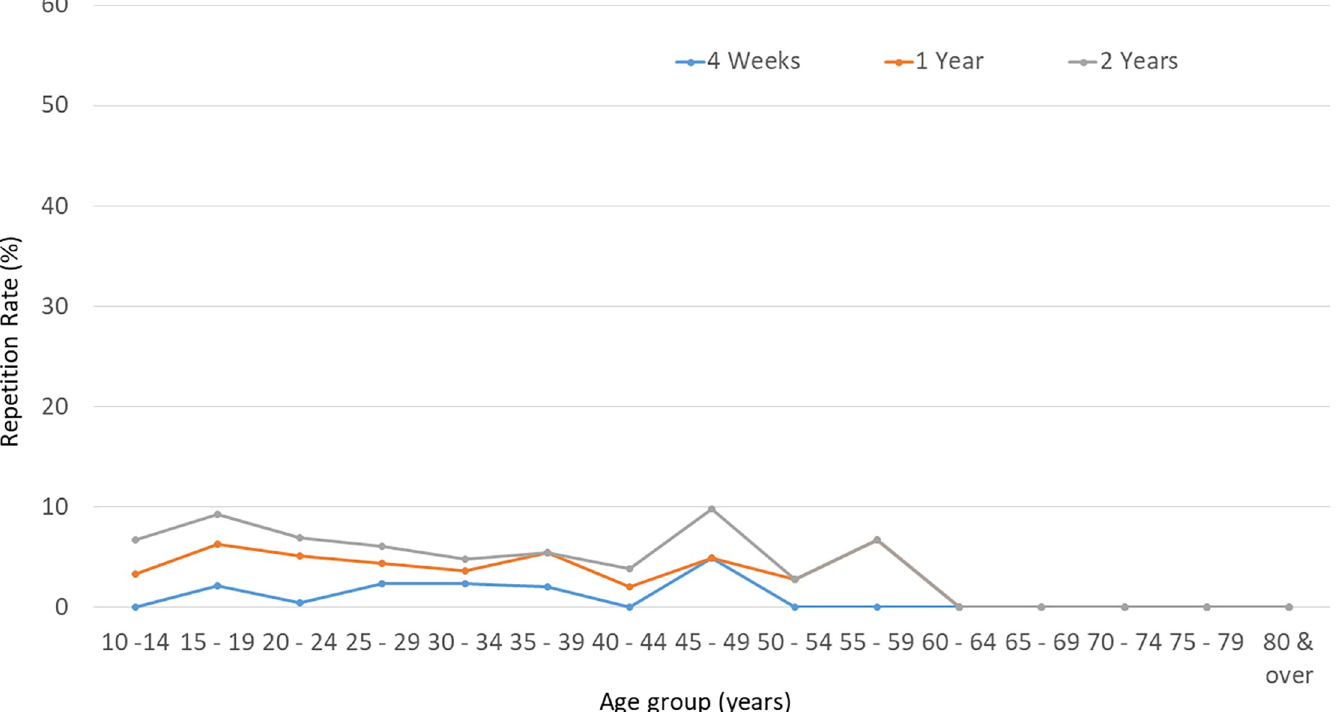
Fig 3. Rate of repetition among females, by age group, at four weeks, one year and two years. Repetition rate, 4 weeks: Number of females in a particular age group with repetitive events within 4 weeks from the indexed event/Female DSP patients in the particular age group of 2011 cohort, One-year: Number of females in a particular age group with repetitive events within a year from the indexed event/Female DSP patients in the particular age group of 2011 cohort, Two-year: Number of females in a particular age group with repetitive events within two years from the indexed event/Female DSP patients in the particular age group of 2011 cohort.